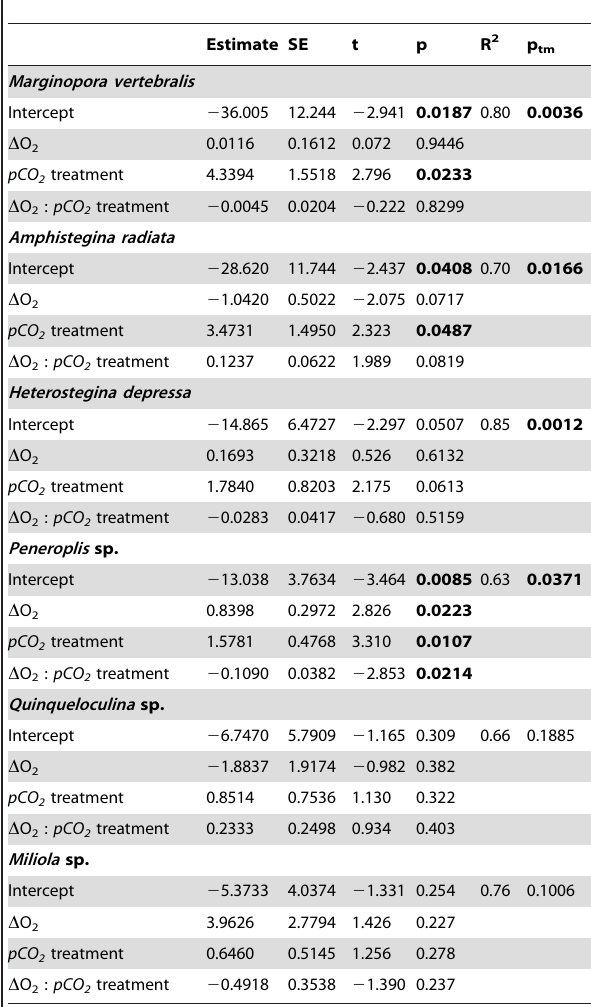
Table 3. Relationships between D O 2 and D H + per individual within each species at different pCO 2 treatments (Figure 7).